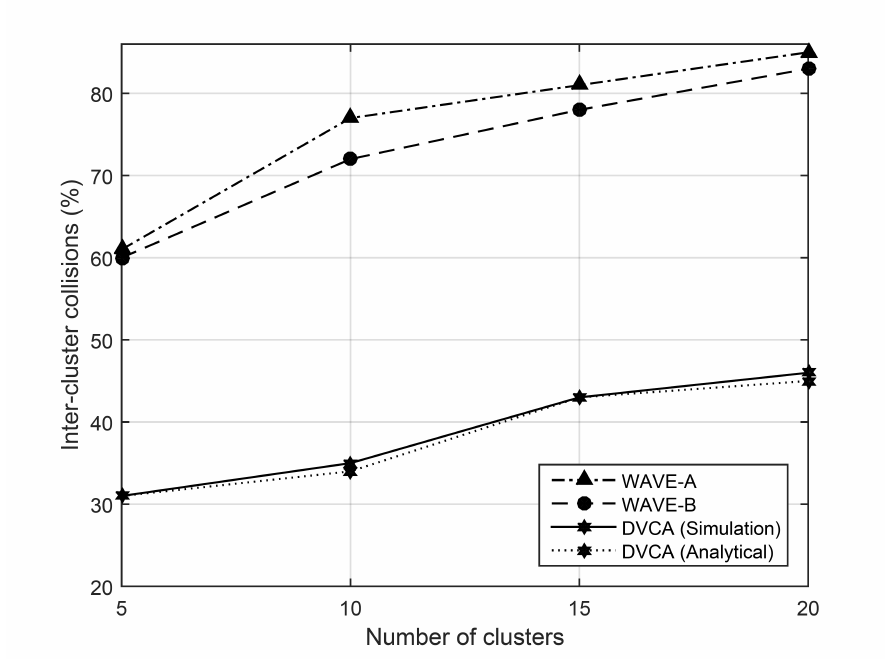
Figure 13. Inter-cluster collision